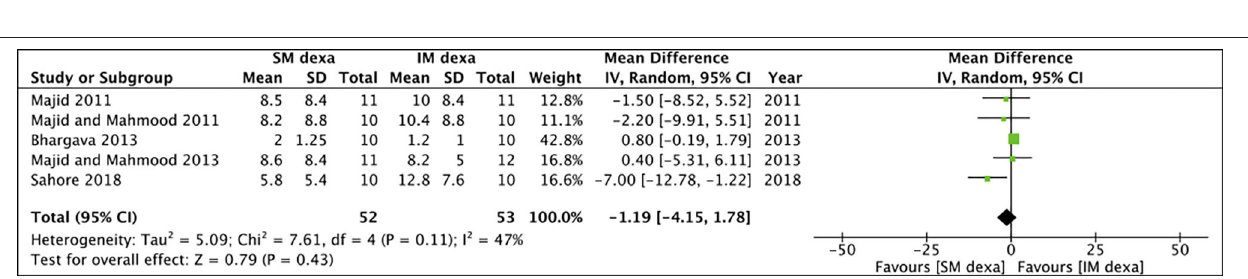
FIGURE 11 | Meta-analysis of late swelling between SM and IM dexamethasone (dexa) for third molar surgeries. Sub-group analysis performed based on final scores or change scores.